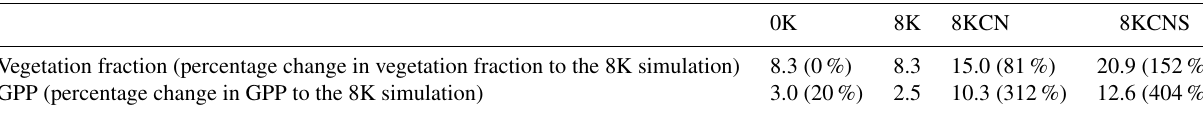
Figure 3. Differences of climate conditions between the 8K and 0K experiment (8K–0K) in summer (June, July, August, and September; JJAS). Differences in downward shortwave radiation (a) , surface net shortwave radiation (b) , 2m air temperature (c) , and cloud fraction (d) . (e, f) JJAS precipitation in the 0K and its differences from the 8K experiment. (g, h) JJAS surface wind vector of the 0K and 8K experiment, respectively. Black squared boxes are the NA (solid), NSS (dotted), and SSS (dashed) areas. Table 4. Vegetation fraction (%) and GPP (gCm − 2 per month) in the SS region. Values in parenthesis are percentage changes in vegetation fraction and GPP to the 8K